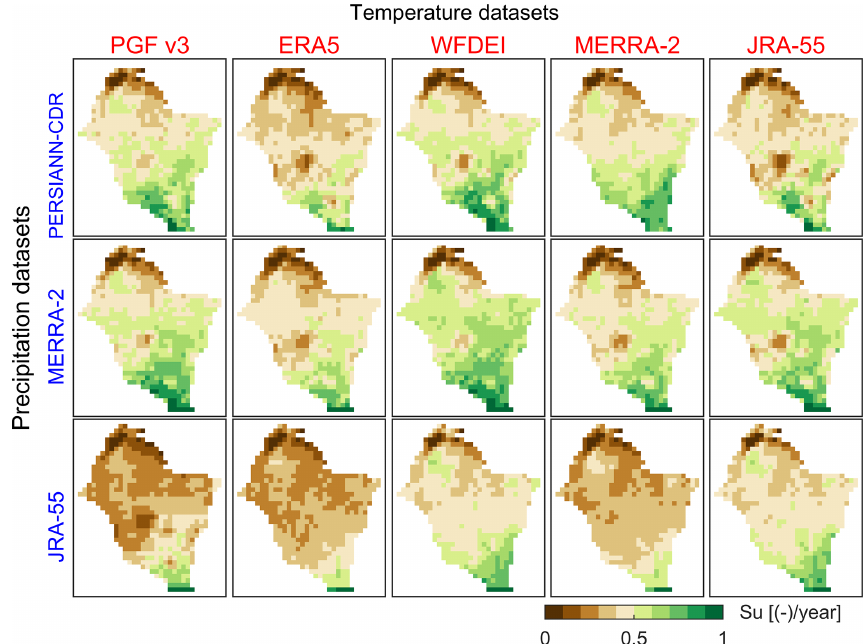
Figure 6. Maps of long-term (2003–2012) average of annual soil moisture ( S u ) obtained with different forcing of rainfall ( y axis, blue font) and temperature ( x axis, red font) datasets. The values are normalized between 0 and 1 to emphasize spatial patterns and to use a unique colour